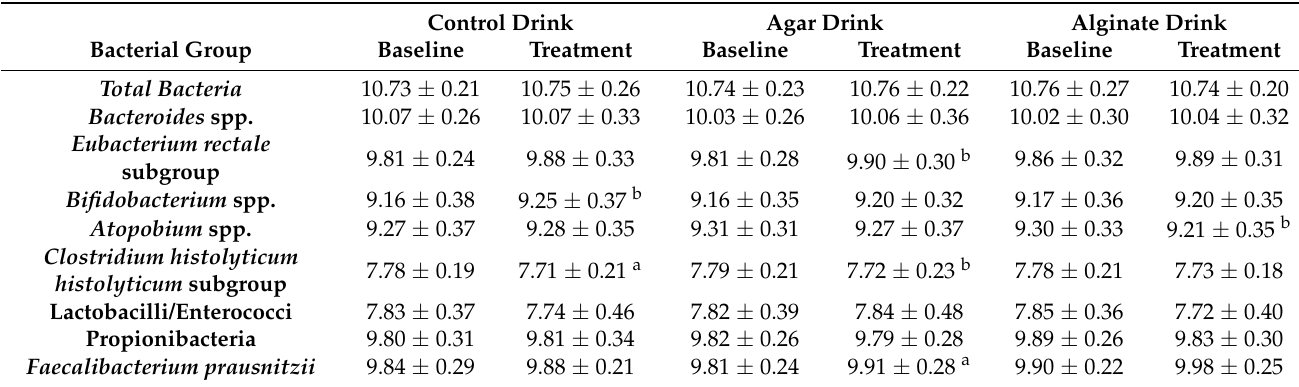
Table 6. Faecal bacterial numbers as determined by fluorescence in situ hybridization for sixty participants over the trial